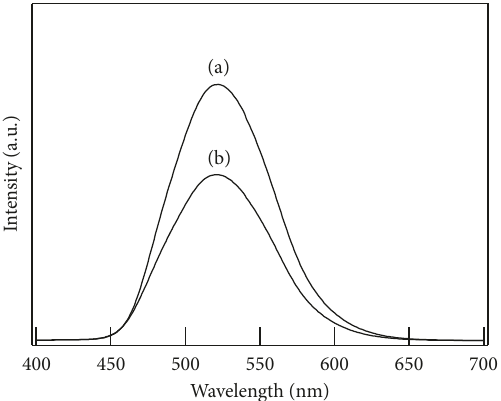
Figure 4: PL spectra of Alq 3 microbelts on the one-step (a) and two-step (b) APA surface. The crystals were formed by treating the APA samples in a 10mM HQ solution at 100 ∘ C for 3min. The excitation wavelength was 370